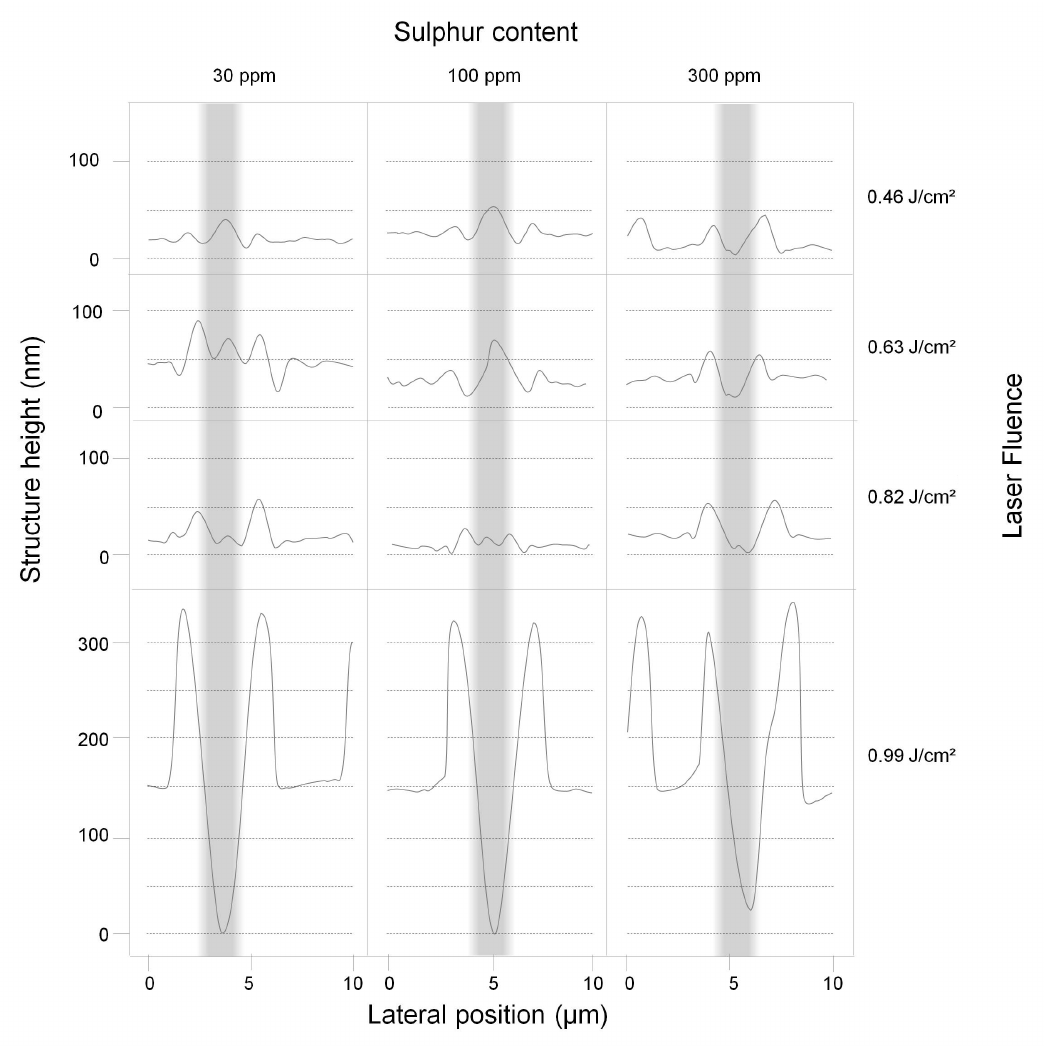
Figure 5. Overview of peak transformation of DLIP structures made on steels with varying sulphur contents. The columns show profiles of produced patterns in steels with sulphur contents of 30 ppm, 100 ppm, and 300 ppm at different laser fluences ( Φ av,spot = 0.46 J/cm 2 , 0.63 J/cm 2 , 0.82 J/cm 2 , and 0.99 J/cm 2 ). The grey highlighted areas represent the regions of maximum laser intensity during